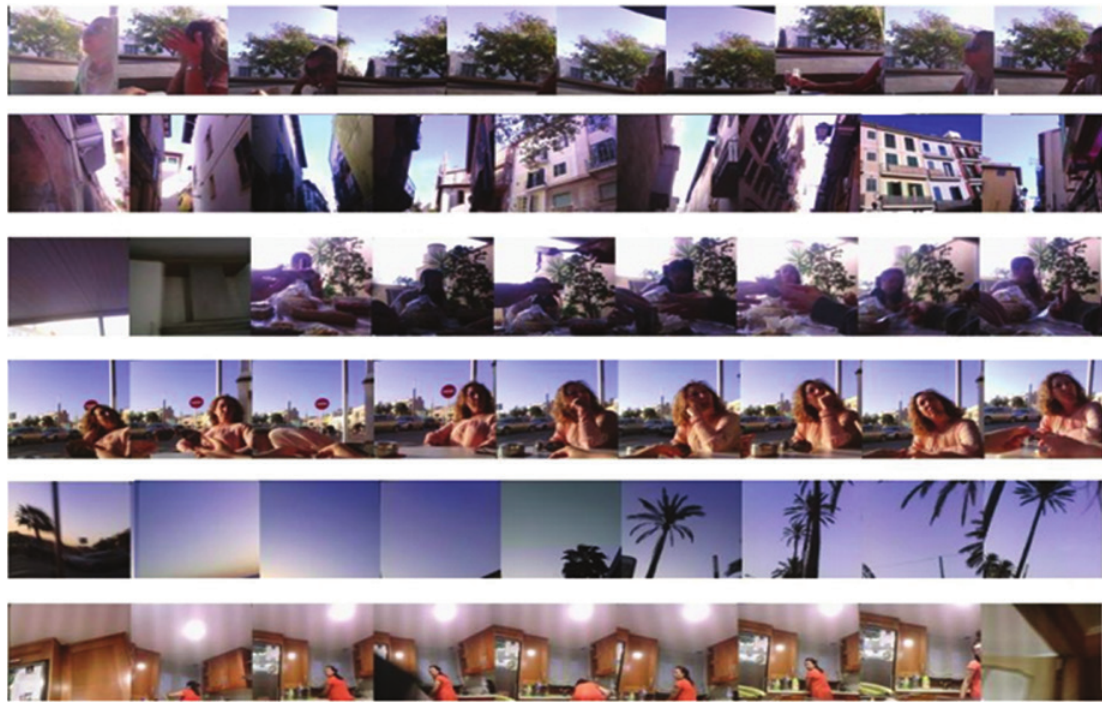
Figure 4: Example of images of the EDUB dataset